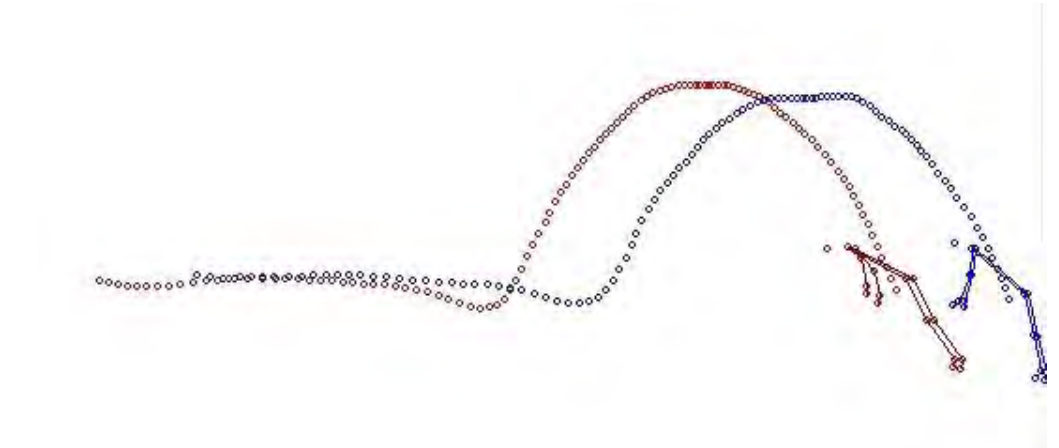
Fig. 7. Phase of finalizing movements with grouped back double somersault after rondat (tested A, variant 1, time 1. 750 sec.) and arched back double somersault after rondat – back turnover (tested B, variant 2, time 1. 683sec.) Body postures on support precede key element FP, i.e. posture of balanced landing (half squatting with forward half bent, arms forward-downward).